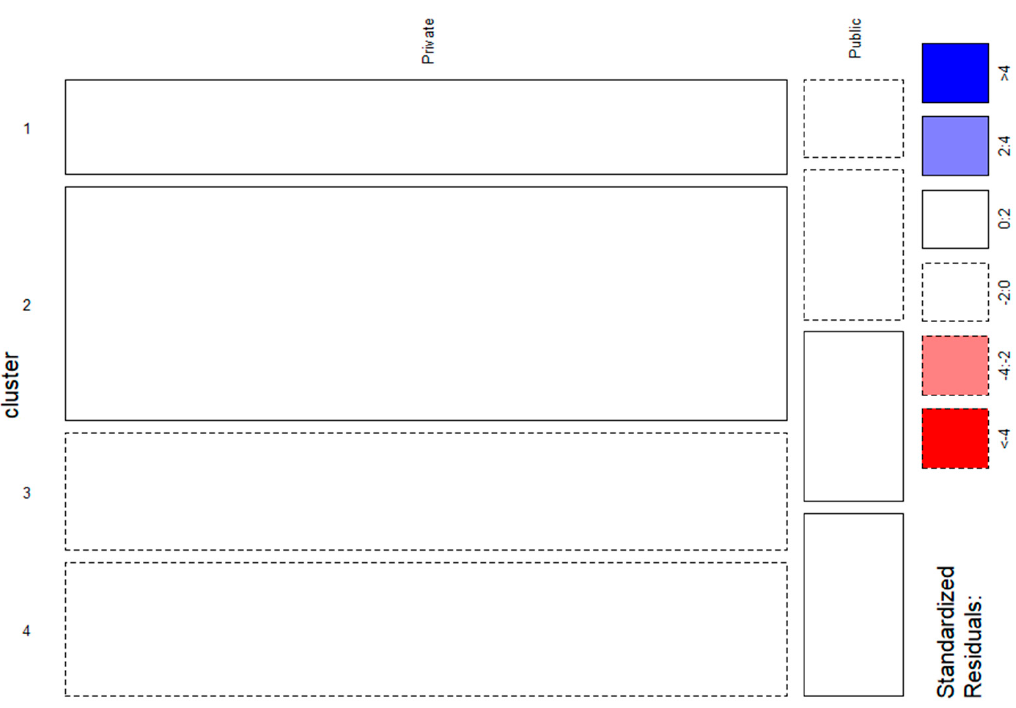
Figure 6. Mosaic plot of cluster membership and type of limited company. Bar heights show percentages of cluster sizes within each company type. High standardized residuals show associations between cluster and company type.